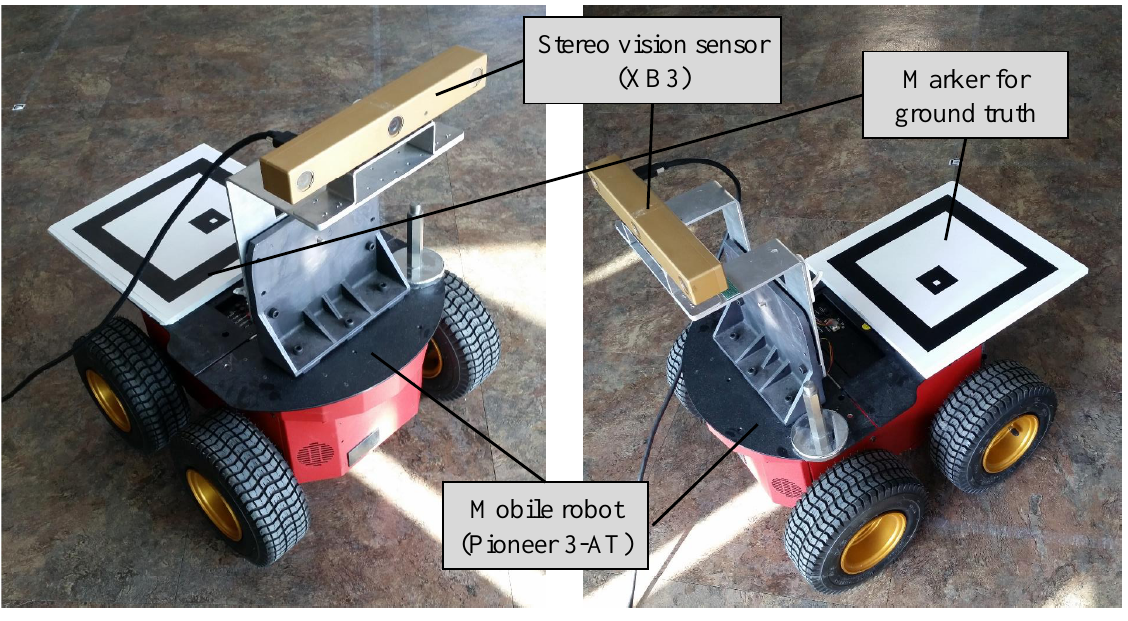
Figure 5. A mobile robot system equipped with a stereo camera. A patterned marker is used for providing ground truth.